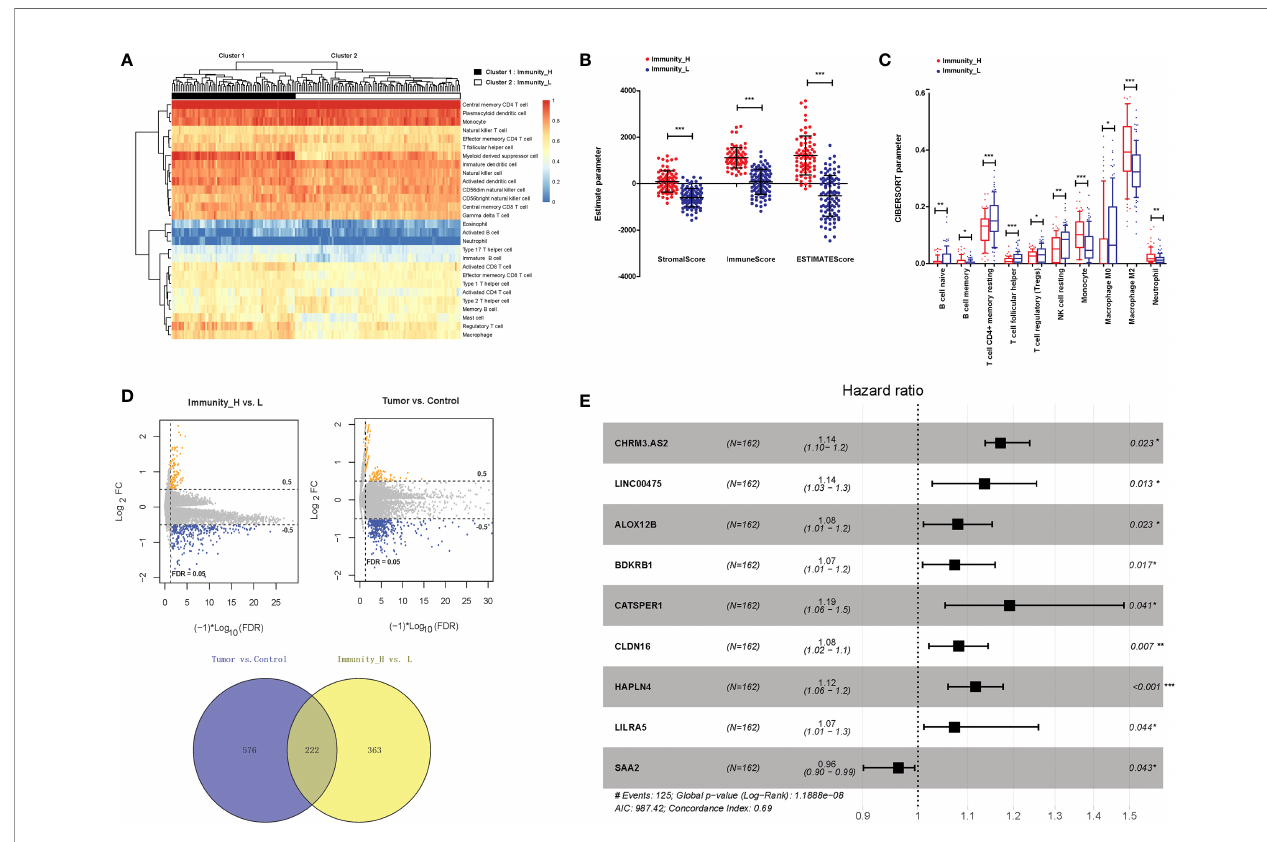
FIGURE 1 | Isolation of DERs in GBM samples. (A) Immune in fi ltration grouping of GBM samples. (B) The stromalScore, immuneScore, and ESTIMATEScore in immunity_H and immunity_L samples. (C) Immune cell types in immunity_H and immunity_L samples. (D) DERs between immunity_H and immunity_L samples and between tumour and normal samples. (E) Forest plots of 9 prognosis-associated DERs (2 lncRNAs and 7 mRNAs). *P < 0.05, ** P < 0.01, ***P <